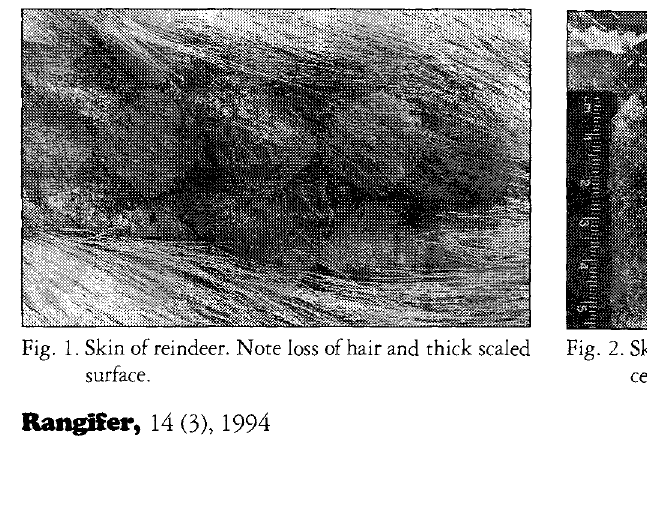
Fig. 2. Skin of reindeer. Note the thick and rugged surfa ce with almost papilloma like